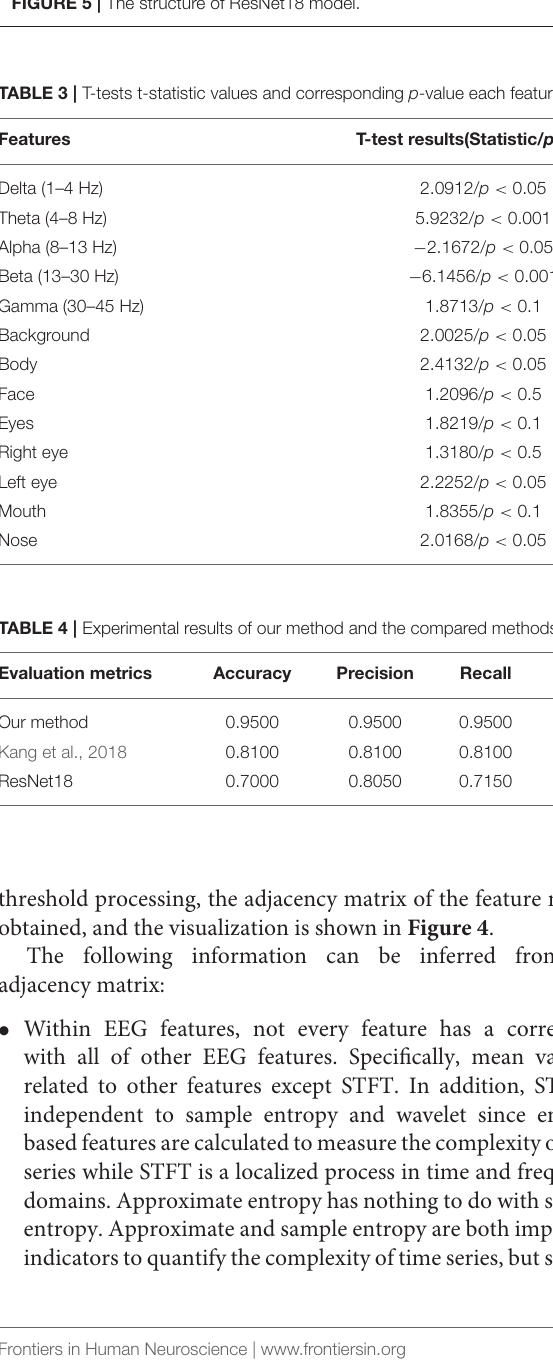
FIGURE 5 | The structure of ResNet18 model.